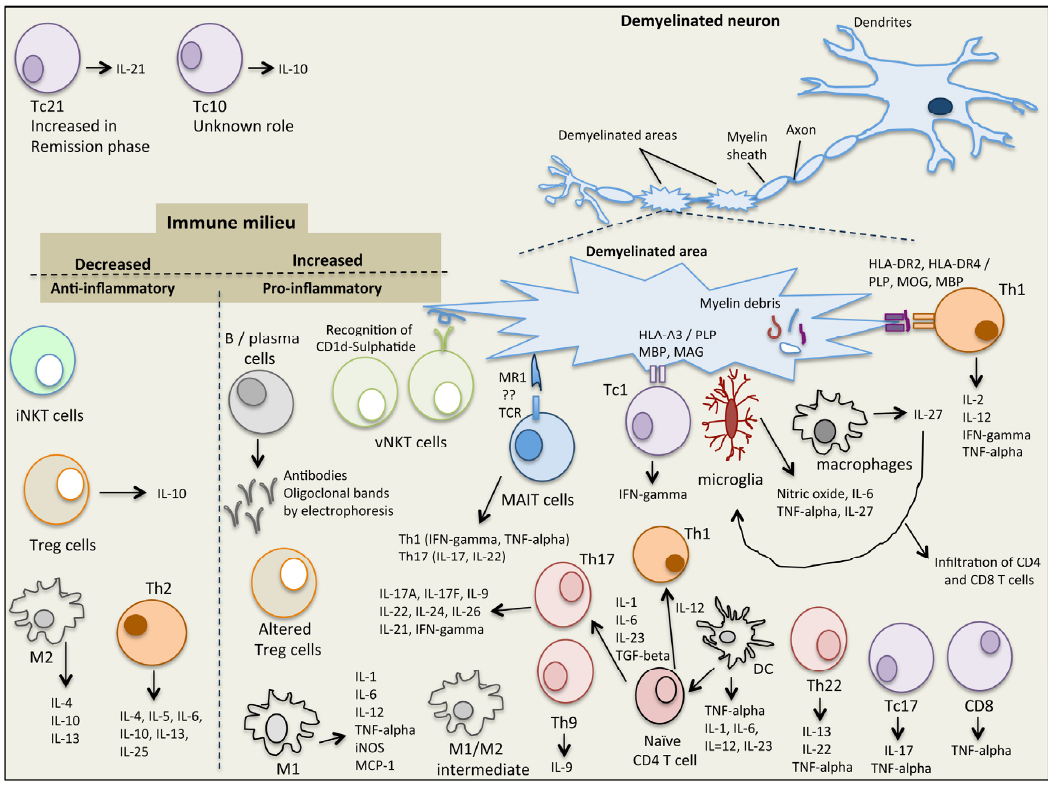
Figure 1. The immunological complexity of the immune/cytokine network in multiple